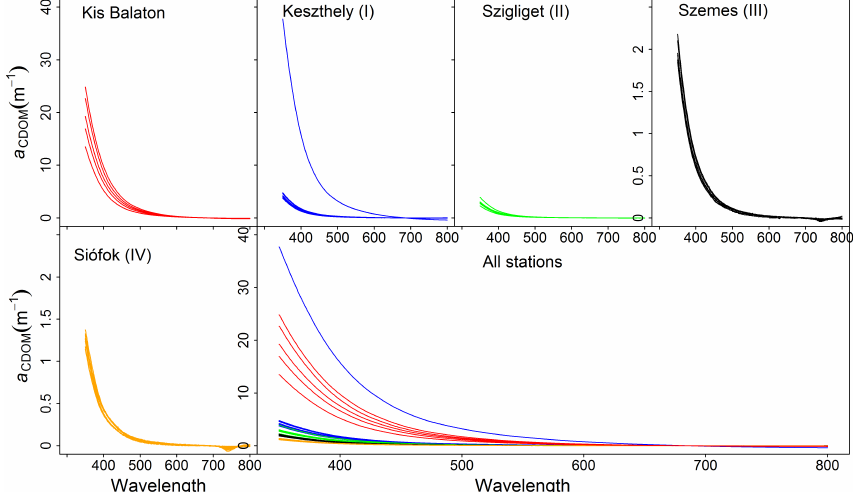
Figure 4. CDOM absorption spectra for all stations (per basin) and Kis-Balaton. Note the different y axis scale for the Szemes and Siófok